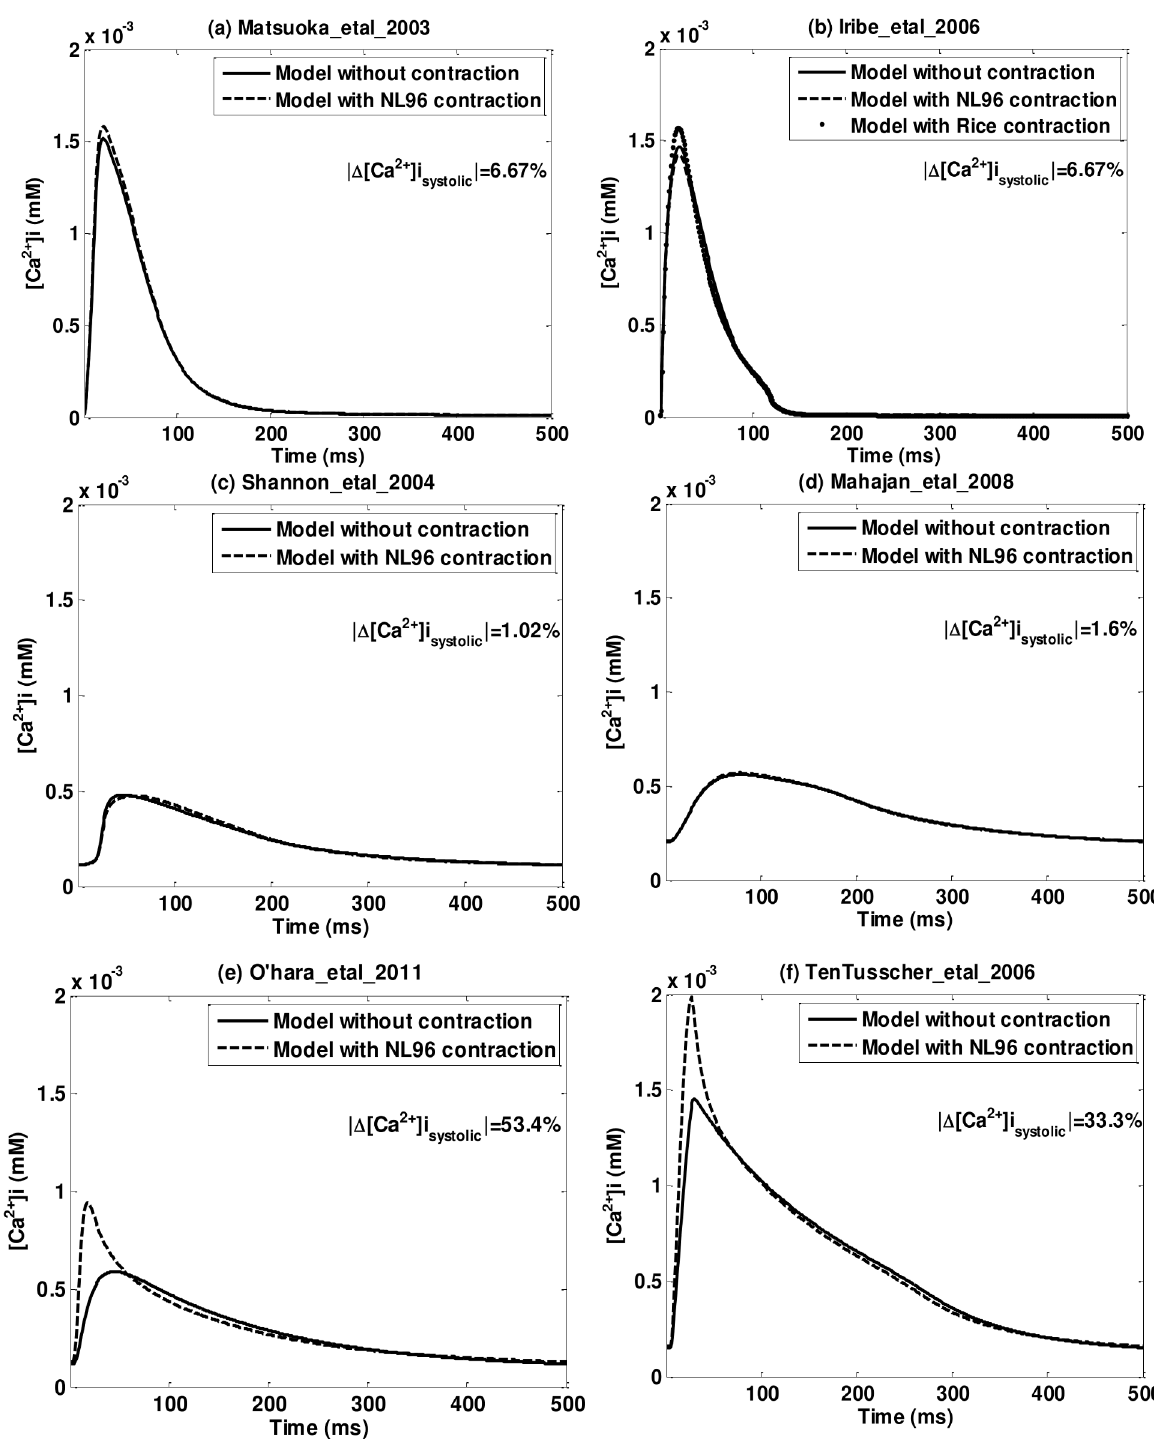
Fig 2. Priming [ Ca 2+ ] i transient for six representative models. (a) Matsuoka_etal_2003 (Type One: with contraction (NL96)); (b) Iribe_etal_2006 (Type One: with contraction (RWH99)); (c) Shannon_etal_2004 (Type Three: with full dynamic calcium buffers); (d) Mahajan_etal_2008 (Type Three: with dynamic calcium troponin buffer); (e) O ’ hara_etal_2011 (Type Four: with instantaneous calcium troponin buffer); (f) TenTusscher_etal_2006 (Type Five: with no calcium troponin buffer). Solid lines are models without contraction; dash lines are models with NL96 contraction. All figures have the same ranges in x and y axis. The insets show the relative difference in systolic [ Ca 2+ ] i between models with contractions and without contractions.